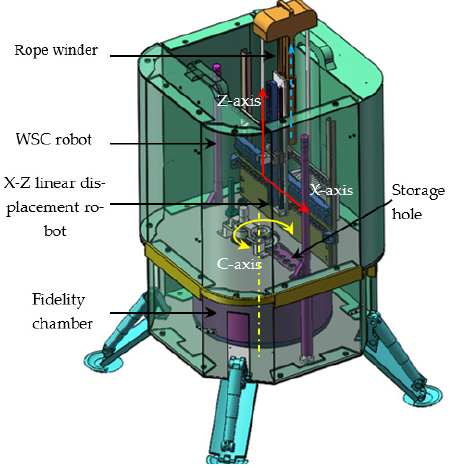
Figure 2. Design of the coring executor.